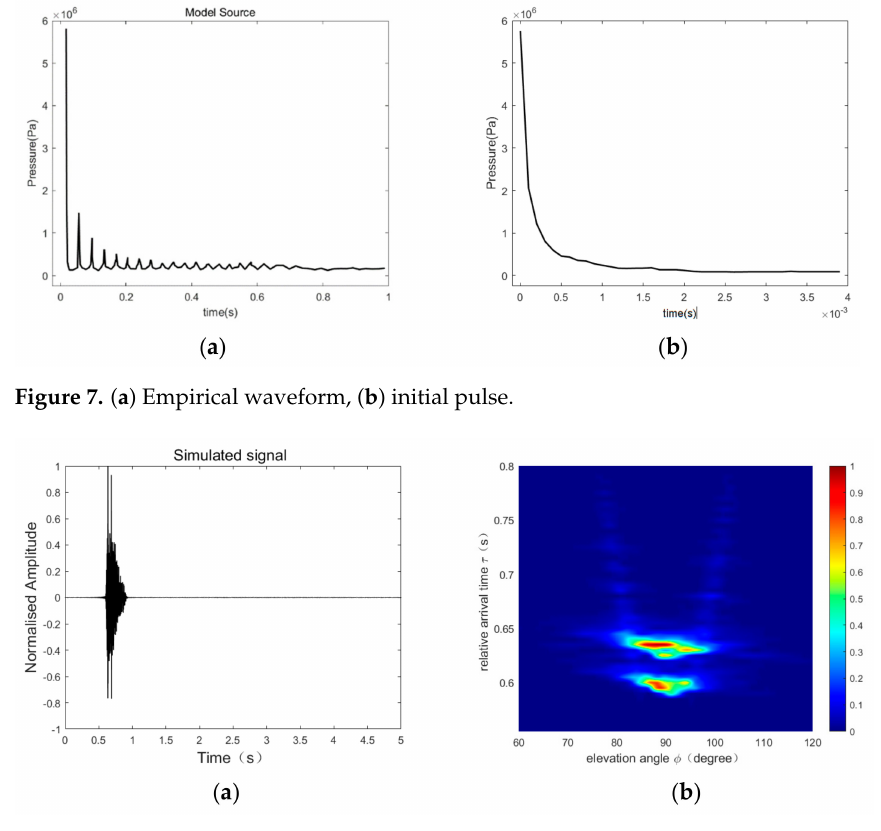
Figure 8. ( a ) Simulated signal and ( b ) beam-time images generated on